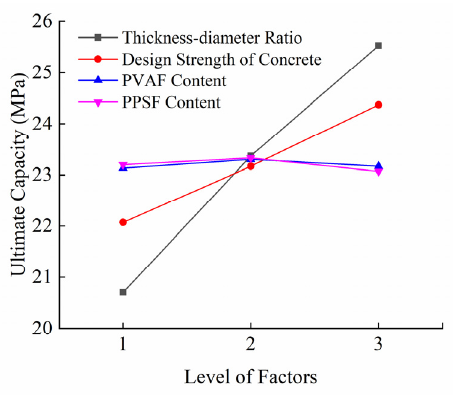
Figure 14. Relation curve of each factor and ultimate capacity of the shaft lining structure.